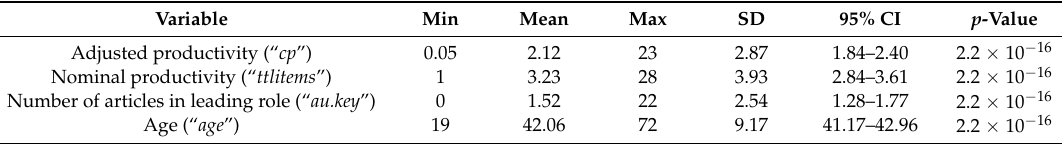
Table A2. Descriptive statistics for variables after the removal of the outlying data points.